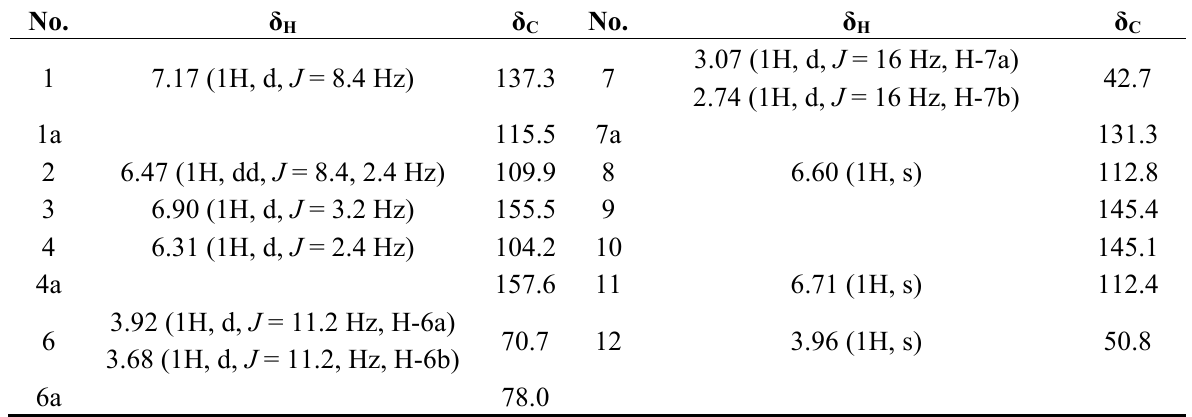
OD, δ in ppm, J in Hz) a . 3